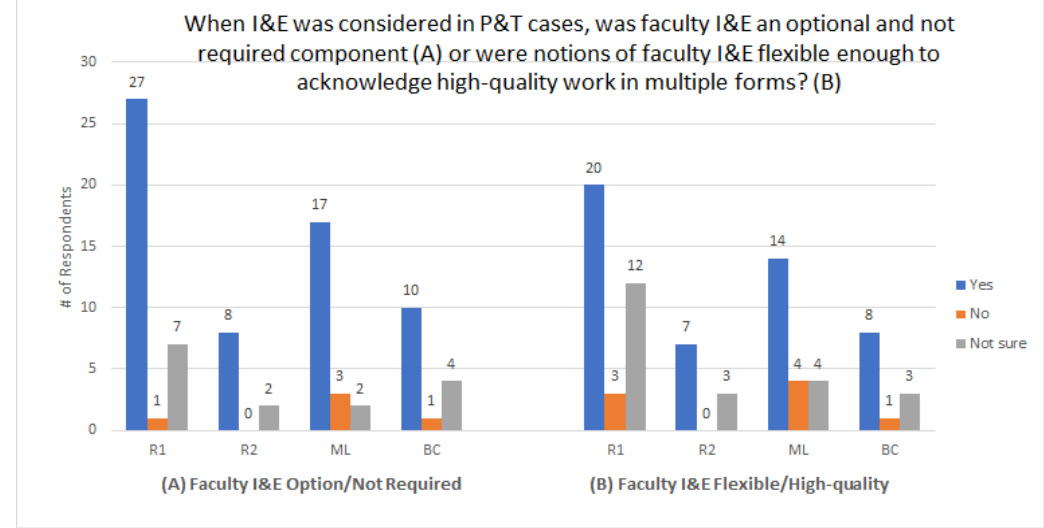
Figure 13. Comparison of institution type responses of level of importance of faculty I&E in P&T cases at institution, school or college, and department levels at their institutions.